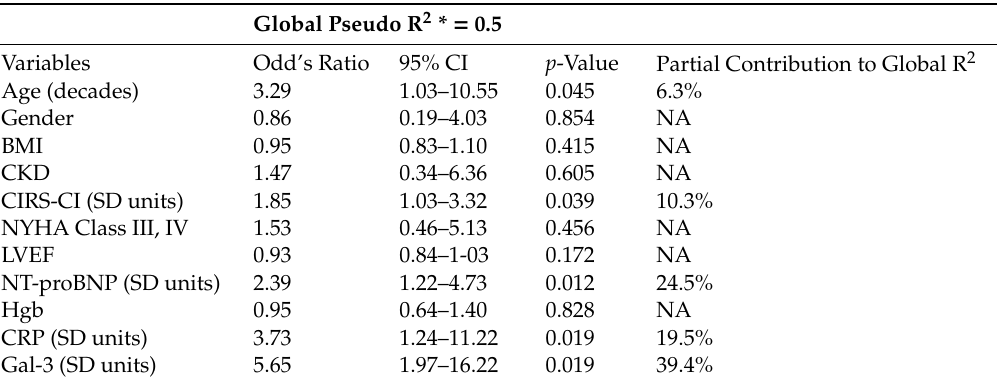
Table 2. Multivariable logistic regression